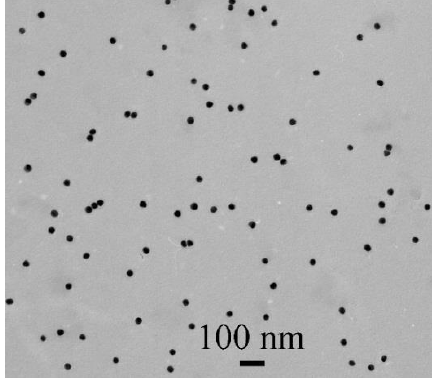
Figure 1. TEM microphotograph of AuNPs.